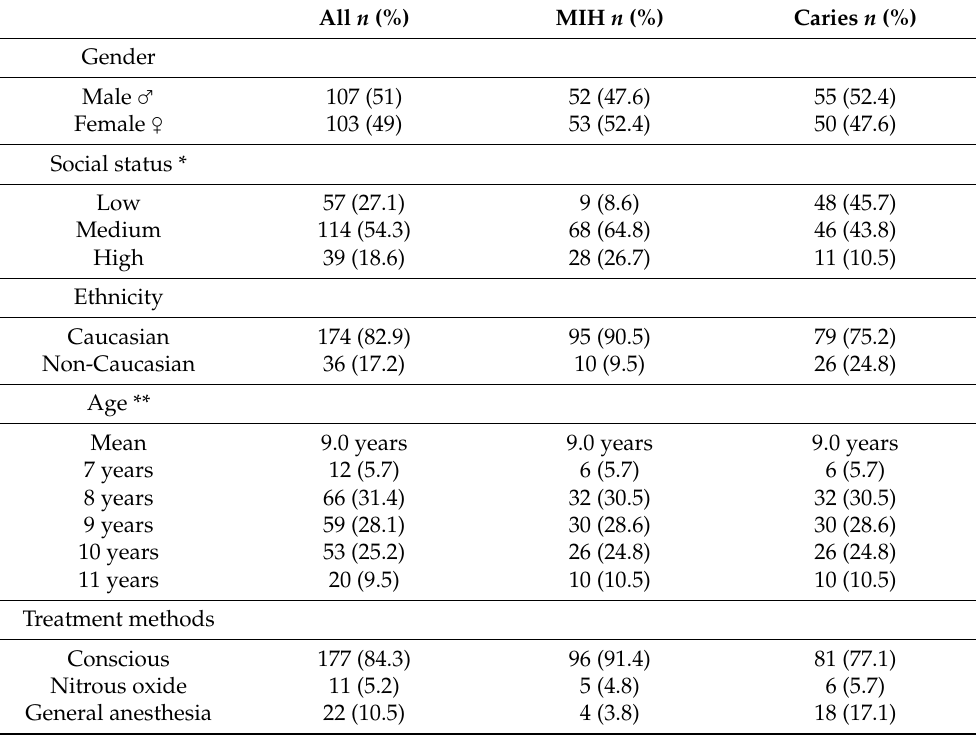
Table 1. Summary of Sample Data ( n = 210 patients). All n (%) MIH n (%) Caries n